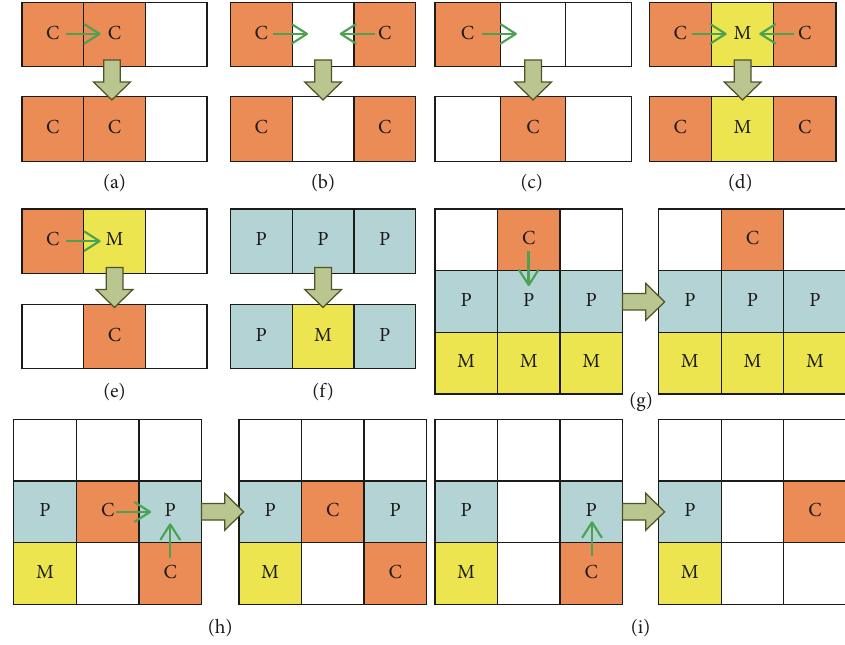
Figure 5: The cellular transformation rule for the corrosion process of high-strength steel